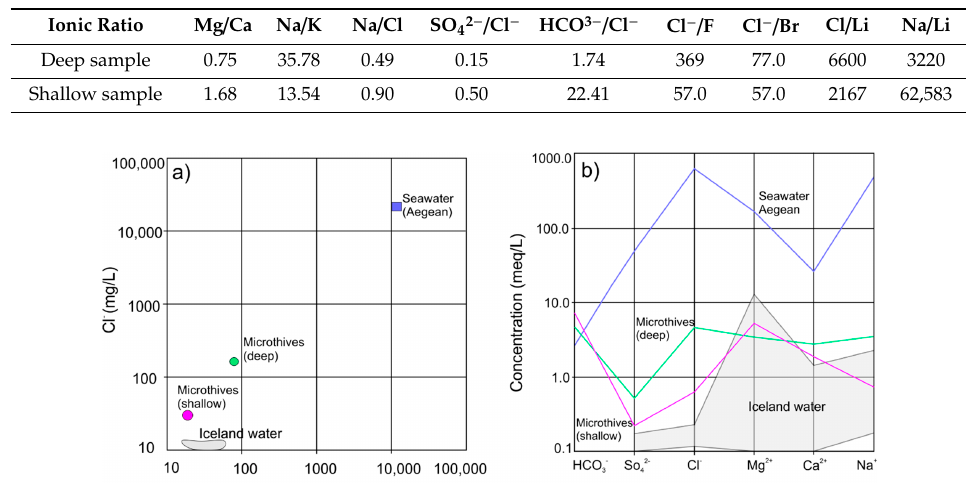
Figure 6. ( a ) Ludwig–Langelier [74] diagram for the water sample of Microthives and the seawater sample from the Aegean Sea. ( b ) Schoeller diagram [75] for the Microthives water sample and the Aegean seawater